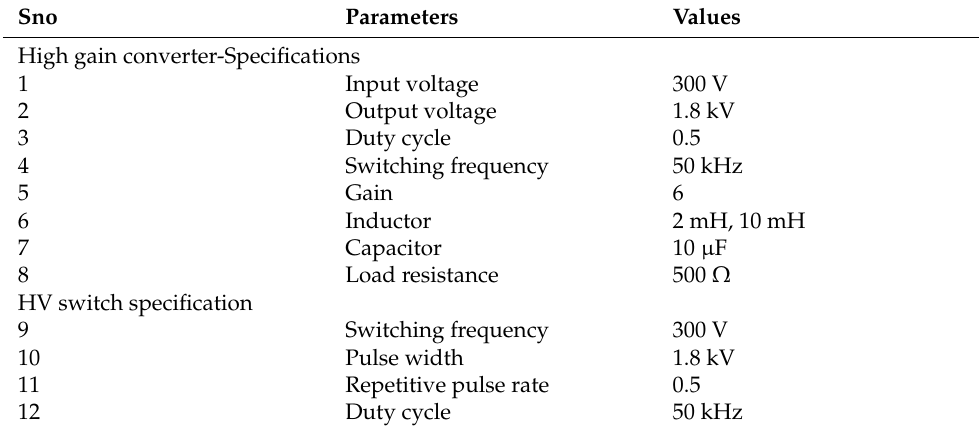
Table 6. Design parameters of PSLSC